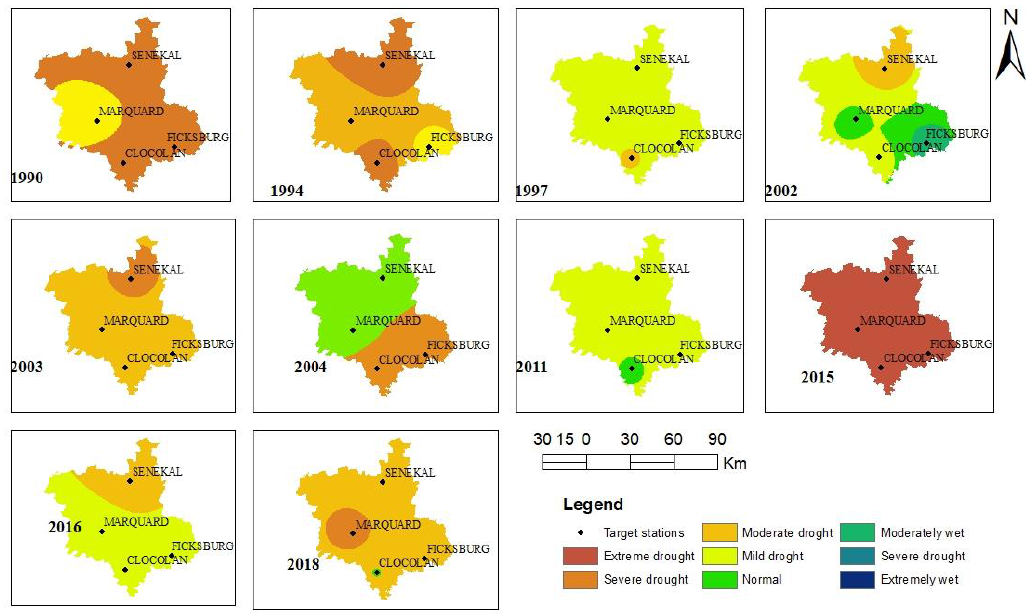
Figure 5. RDI-3 spatial-temporal patterns of drought in Setsoto municipality (1985–2019) based on RDI values.